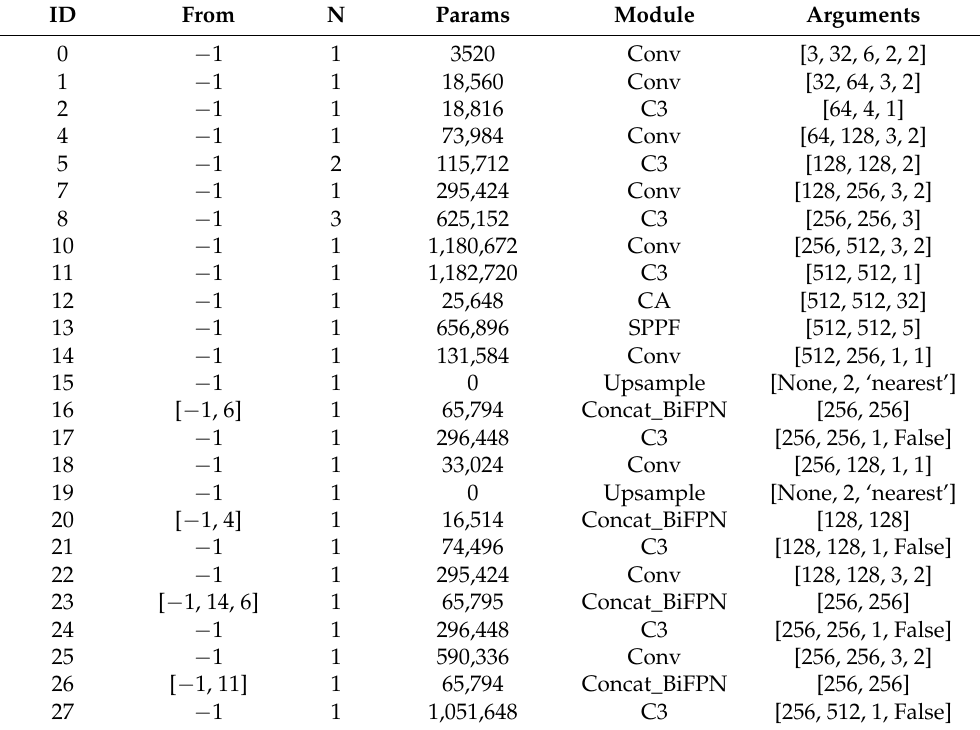
Table 1. Improved YOLOv5